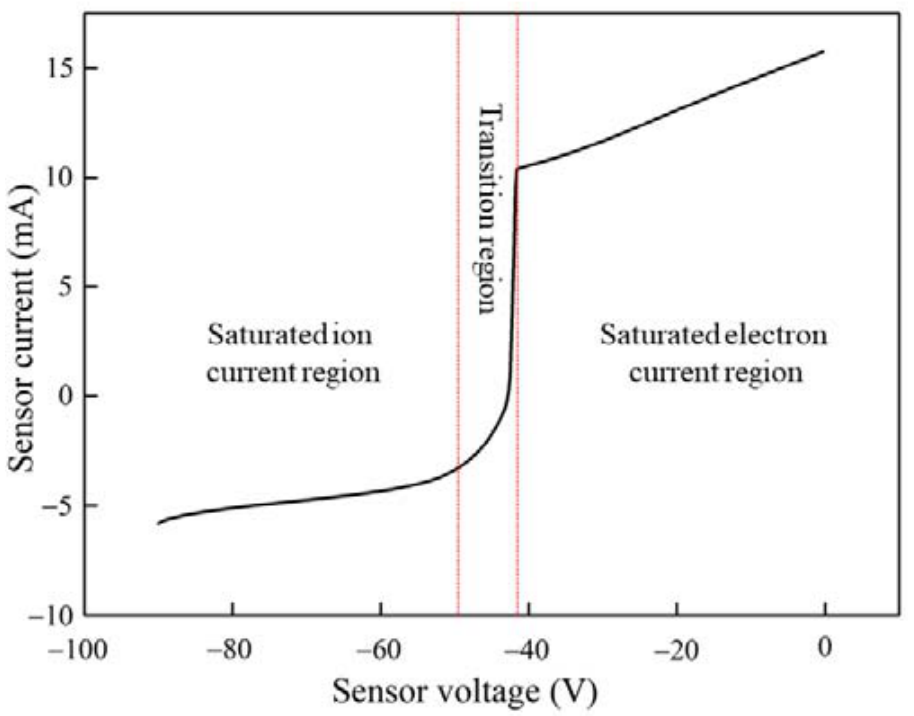
Figure 2. I – V characteristic of wall probe at atmospheric pressure with a flow rate of 5 mL/min for He and the discharge current of 10.7 mA, which has a consistent I – V characteristic obtained by traditional Langmuir probe with the saturated electron and saturated ion current region and the transition region.